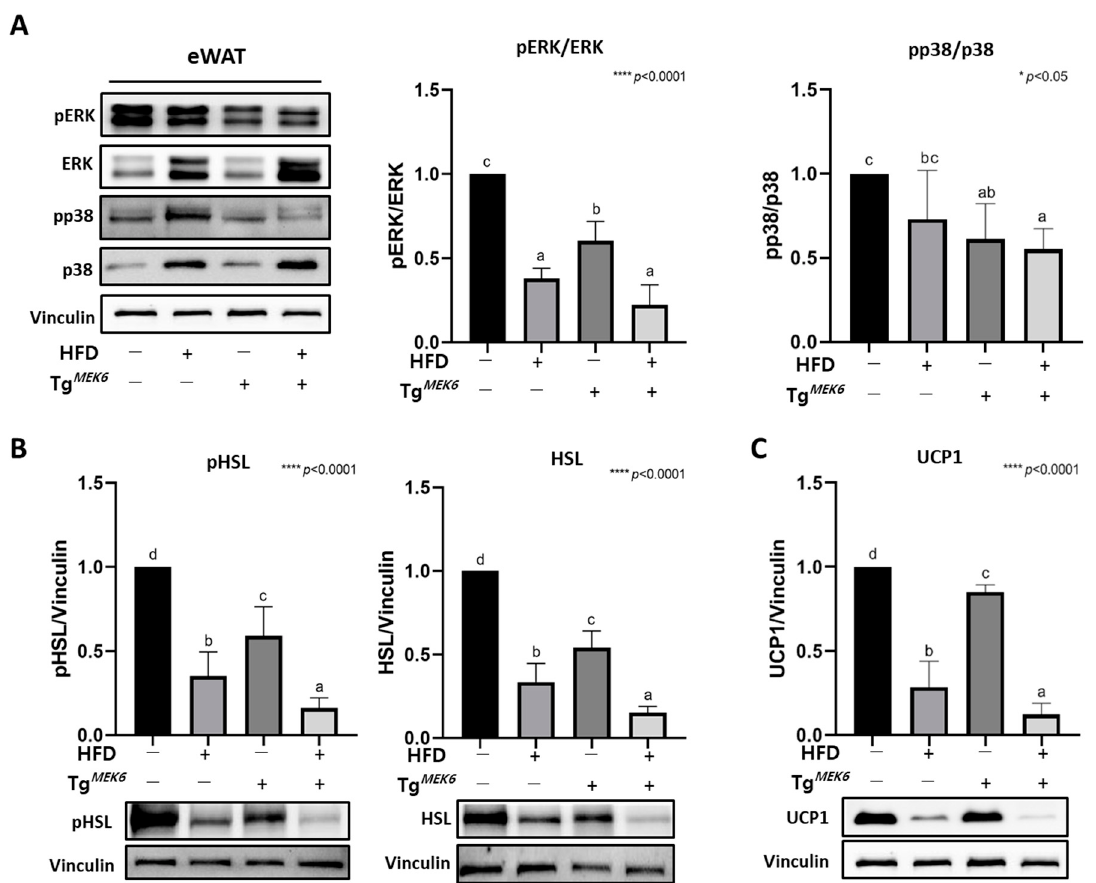
Figure 2. Overexpression of MEK6 modulates MAPK family (ERK/p38) activation and protein expression related to lipolysis and thermogenesis in eWAT. ( A ) Expression of proteins (pERK, ERK, pp38, p38) related to MAPK family in eWAT. ( B ) Expression of proteins (pHSL, HSL) related to lipolysis and ( C ) protein (UCP1) related to beiging in eWAT. Results are expressed as mean ± SD. Data were assessed by one-way ANOVA with Duncan’s test (NS, not significant by unpaired t ‐ test. *; p < 0.05, ****; p < 0.0001). Superscript letters (a–d) indicate the significant differences between the groups at p < 0.05. +, treatment or transfection; − , non ‐ treatment or non ‐ transfection.